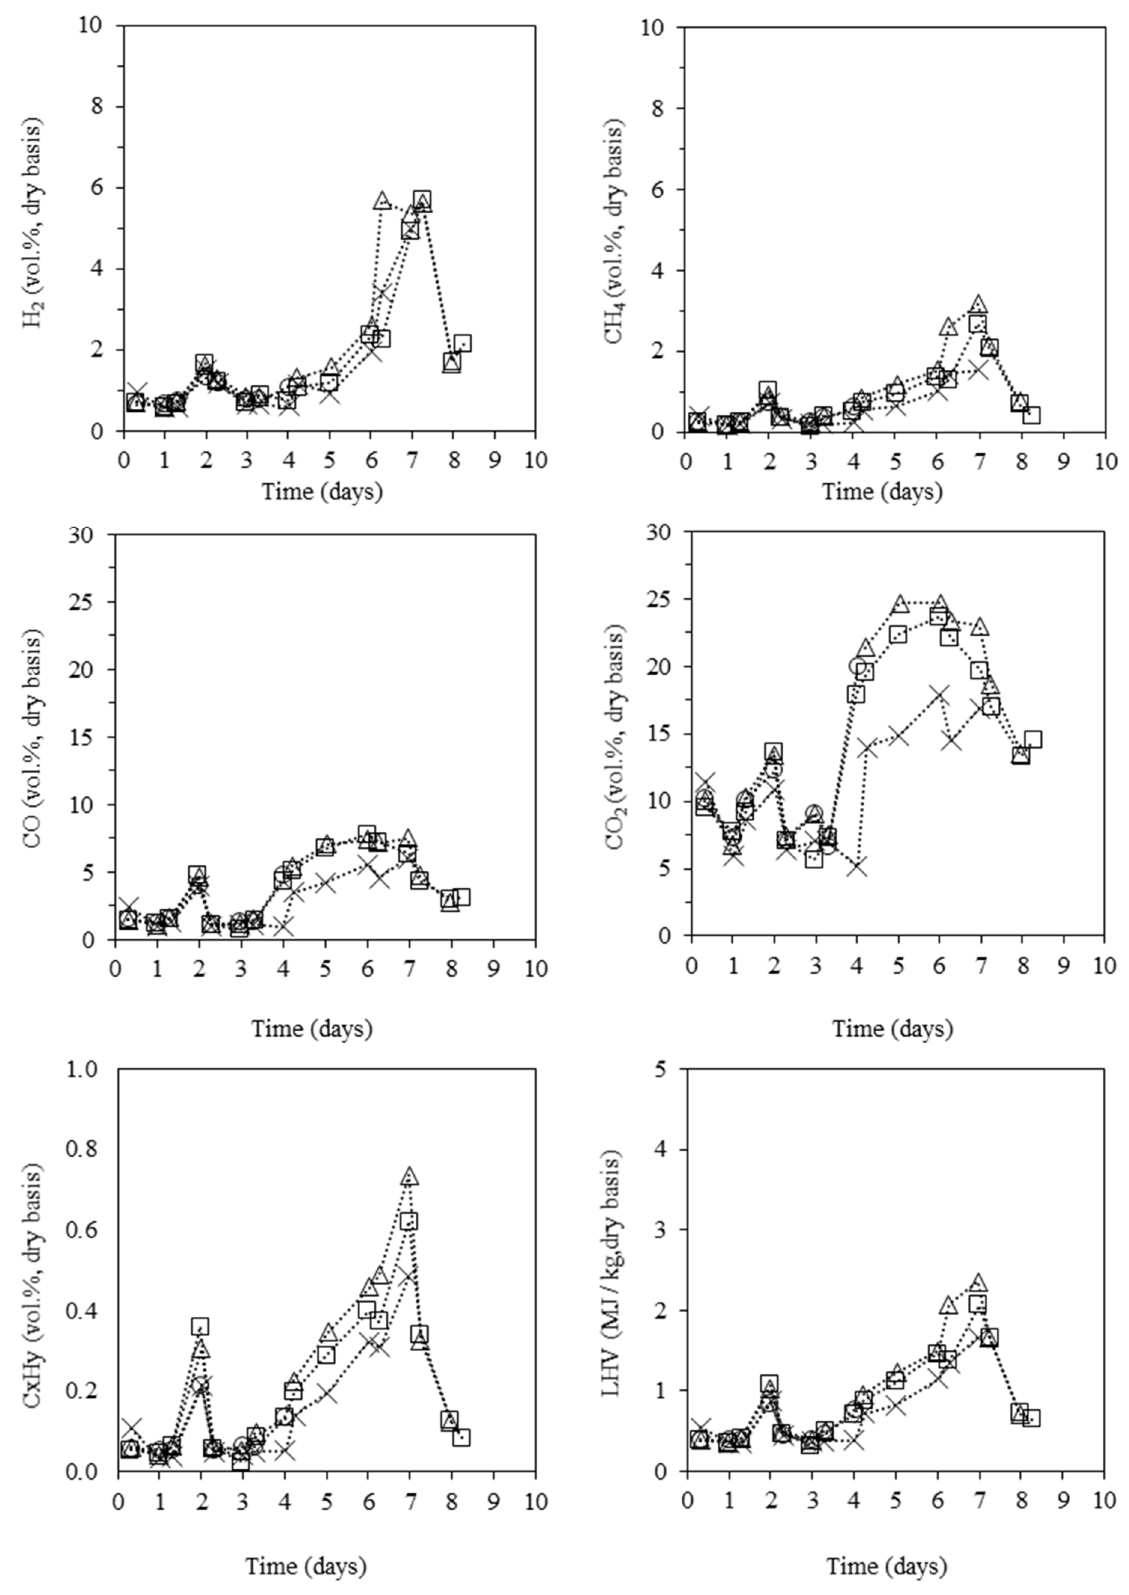
Figure 6. Concentrations of N 2 O 2, H 2 , CH 4 , CO, CO 2 , C x H y , and LHV of the dry clean carbonization gas leaving the kiln. Squares—chimney S4, triangles—chimney S3, circles—chimney S2, crosses—chimney S1.